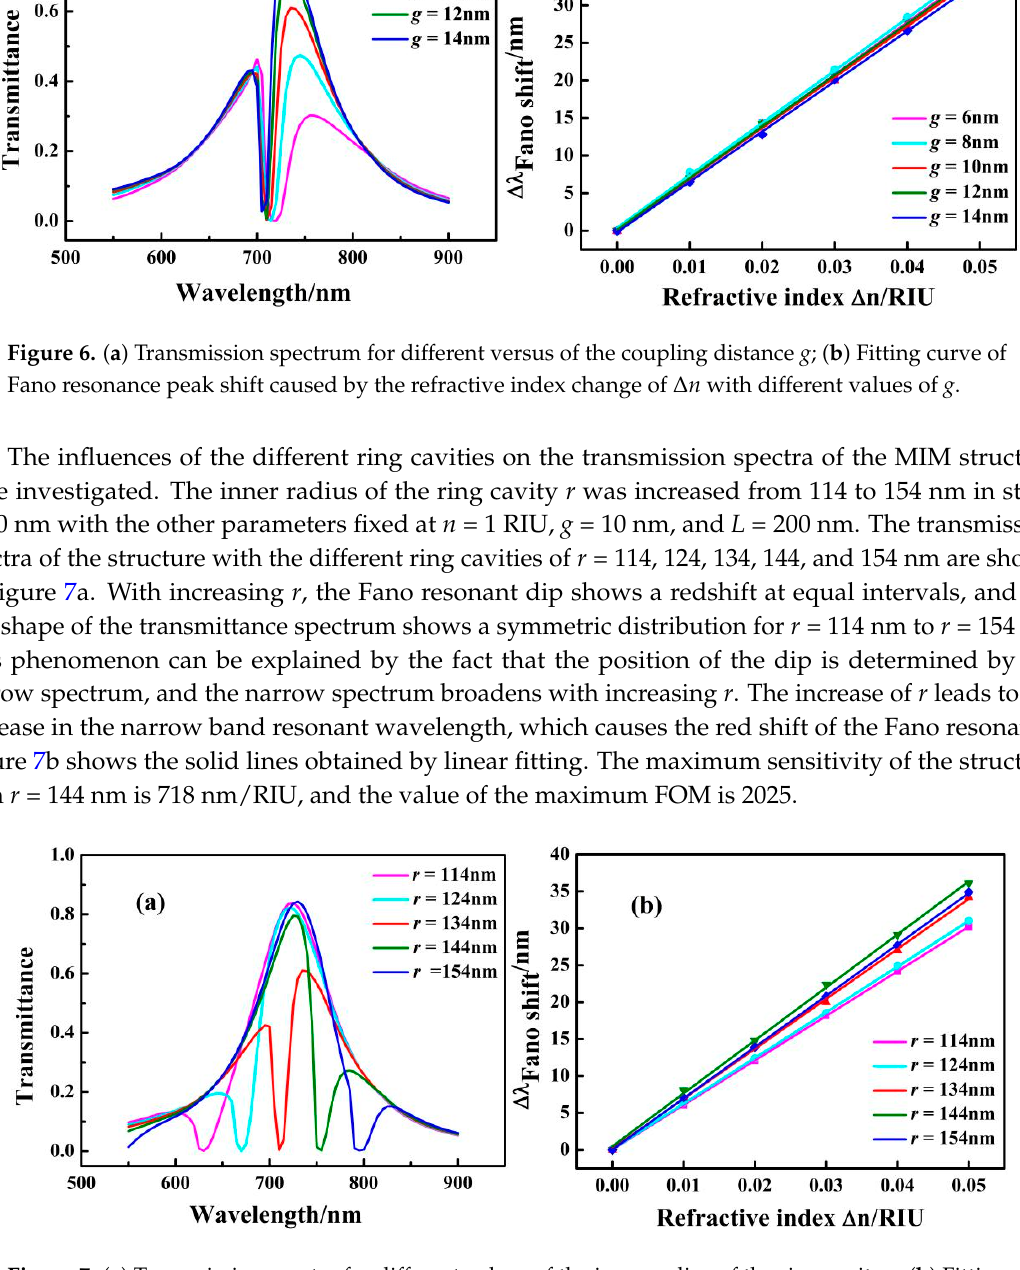
Figure 7. ( a ) Transmission spectra for different values of the inner radius of the ring cavity r ; ( b ) Fitting curves of Fano resonance peak shift caused by the change in the refractive index of Δ n with different values of r